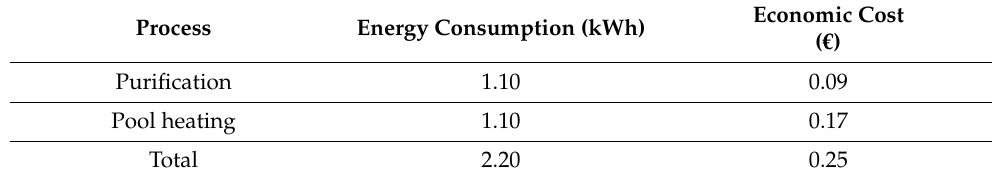
Table 5. Daily energy consumption and economic cost of each process in scenario 3.